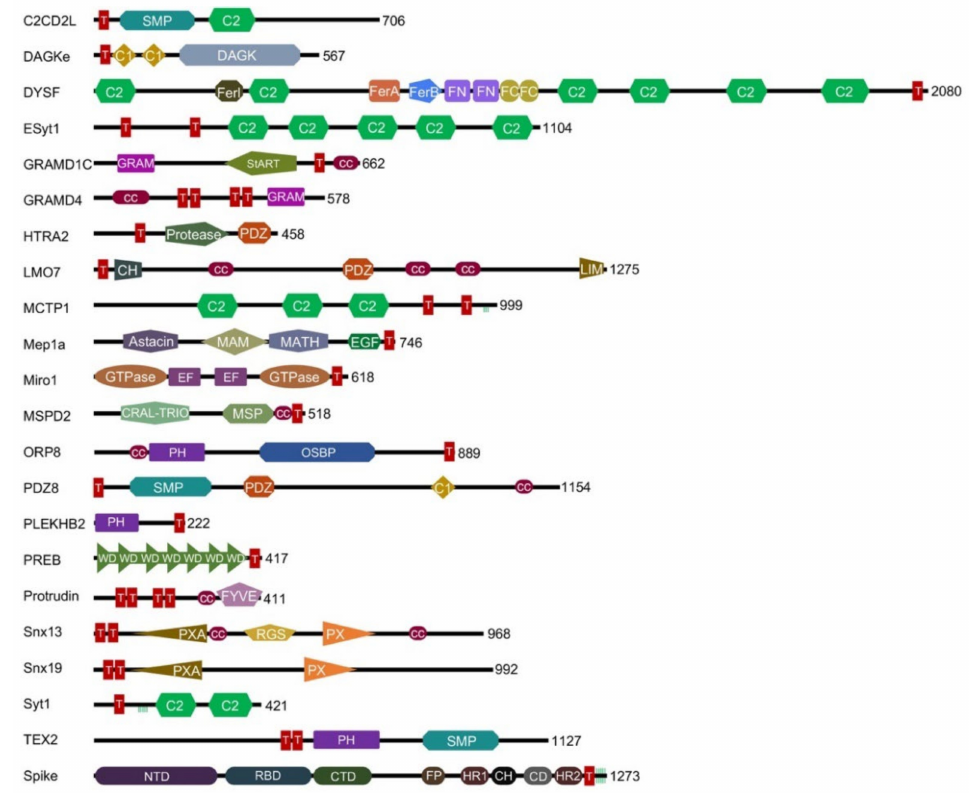
Figure 1. Domain architectures of TMMR proteins. Selected representatives of the diverse families of human TMMRs as well as the SARS-CoV-2 spike protein are shown. Each protein is labelled with its name, structural domains, and length. TM regions are depicted as red rectangles containing a “T”. Palmitoylated cysteines are shown as short vertical green